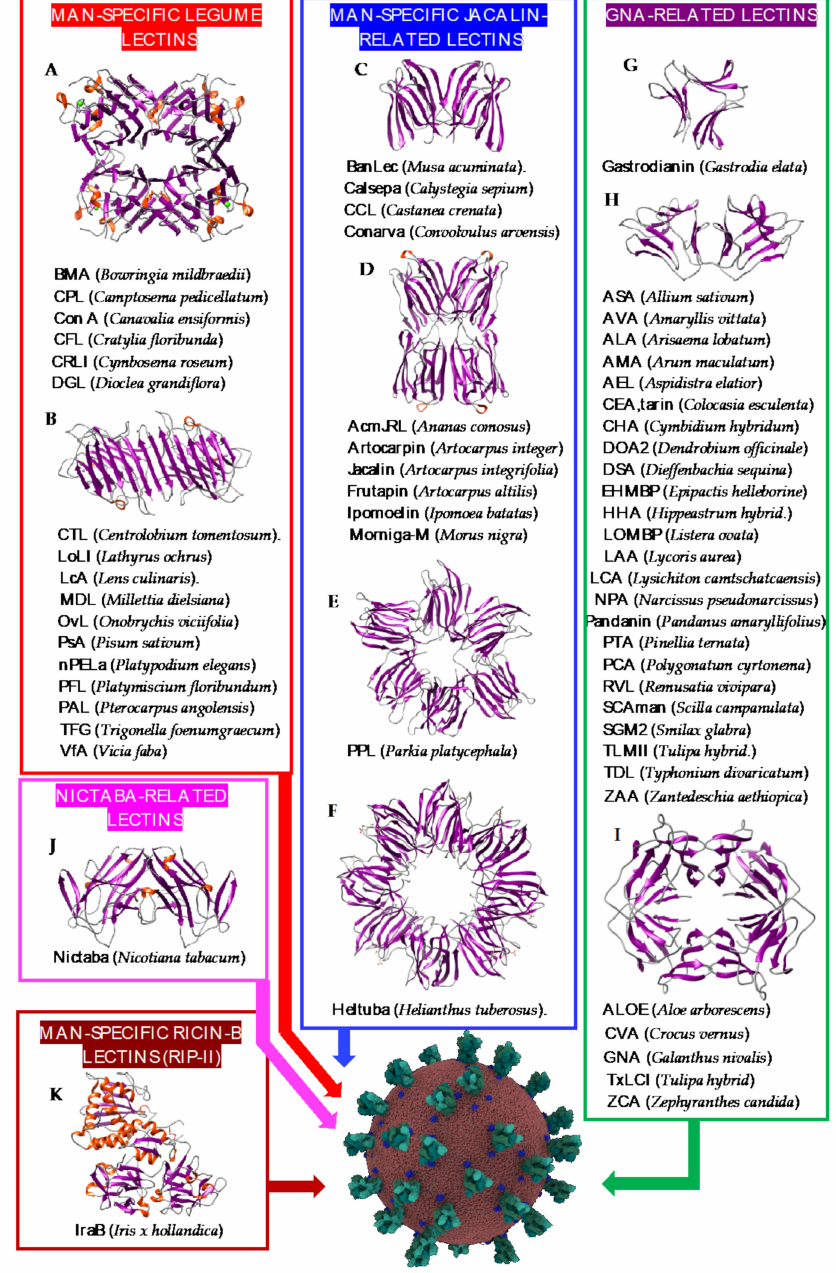
Figure 2. Overview of lectins from representative genera/species belonging to higher plant families, with their associated structural scaffolds, able to recognize the spike proteins from coronaviruses ( Coronavirus Credit: Maria Voigt/RCSB PDB). A-K correspond to lectins used as structural scaf- folds (( A ): Con A, ( B ): LcA, ( C ): BanLec, ( D ): Morniga-M, ( E ): PPL, ( F ): Heltuba, ( G ): Gastrodianin, ( H ): ASA, ( I ): GNA, ( J ): Nictaba, ( K ): IraB. References [41–98] correspond to the lectins presented in the